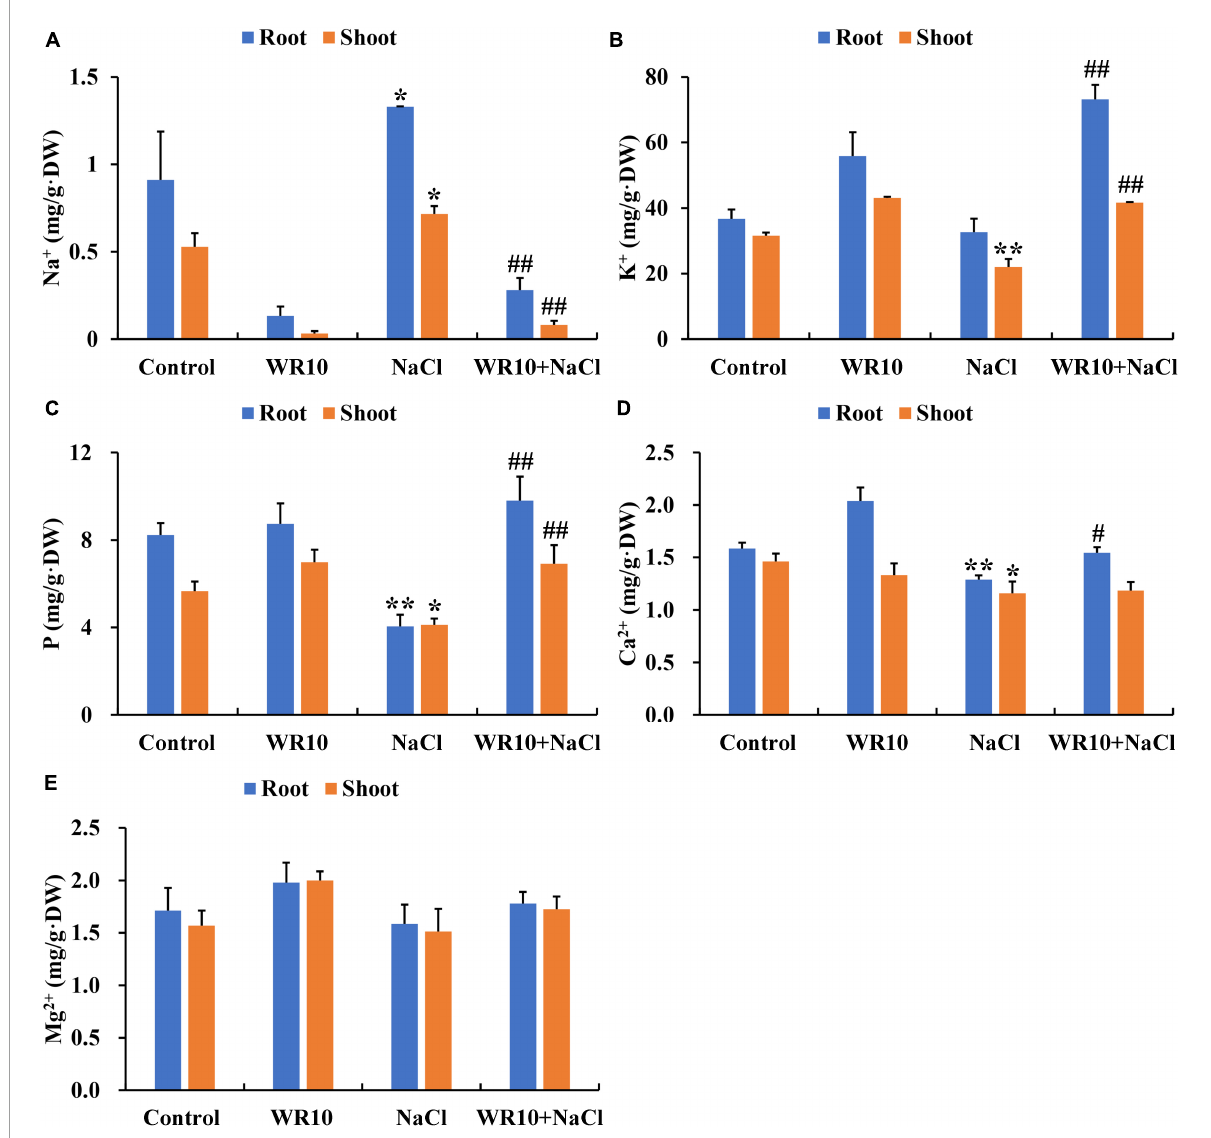
FIGURE2 Effects of B. altitudinis WR10 on the levels of Na + (A) , K + (B) , P (C) , Ca 2 + (D) , and Mg 2 + (E) in the roots and shoots of wheat seedlings under salt stress. Control, without NaCl and WR10; WR10, with WR10 and without NaCl; NaCl, with NaCl and without WR10; WR10 + NaCl, with NaCl and WR10. Data are expressed as the means ± SD ( n = 6). * p < 0.05, ** p < 0.01 (vs. control); # p < 0.05, ## p < 0.01 (vs.